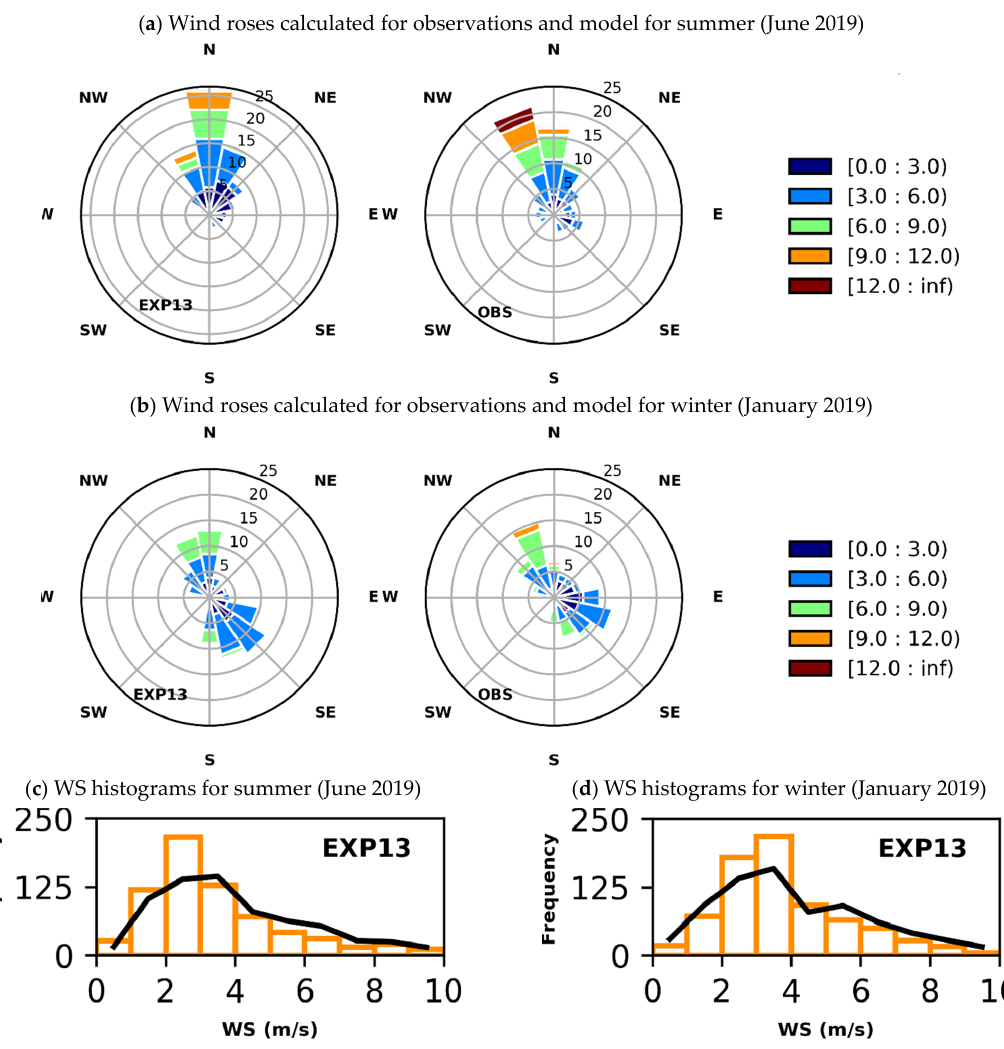
Figure 14. 10-m wind roses and wind speed histograms calculated for model and observations at Aljazeera for June and January 2019. ( a , b ) denote the observed and the simulated wind roses for June and January respectively. ( c , d ) show respectively the observed (black curve) and the simulated (orange curve) histograms for June and January 2019.